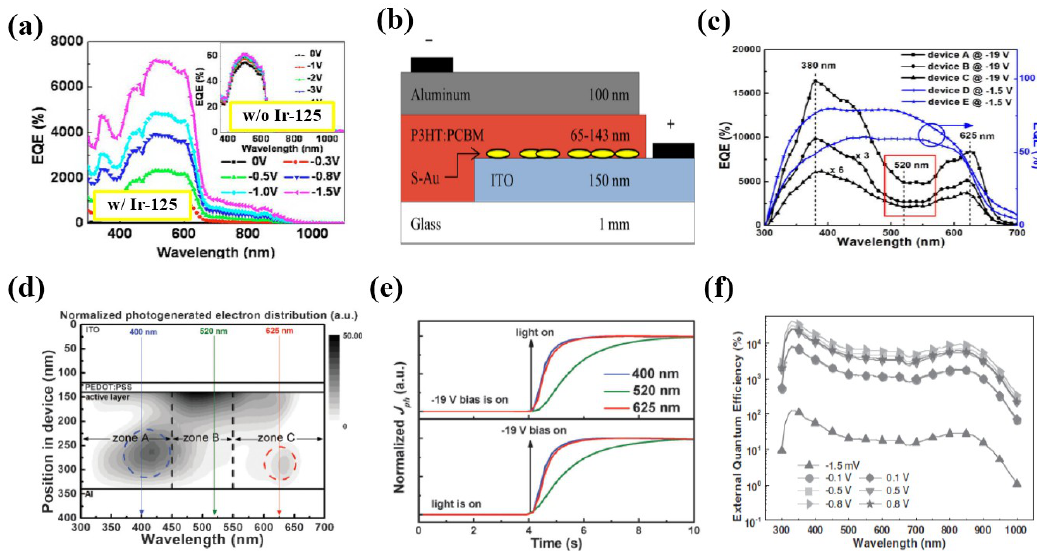
Figure 4. Device performances of various polymer PM photodetectors based on bulk heterojunctions made of organic semiconductors. ( a ) EQE spectra of ITO/PEDOT:PSS/P3HT:PCBM (1:1)/Ca/Al with and without Ir-125 doped in active layer (Reproduced with permission from [60]. AIP Publishing , 2010); ( b ) Structural diagram of ITO/s-Au/P3HT:PCBM/Al device (Reproduced with permission from [61]. AIP Publishing , 2014); ( c ) EQE spectra of ITO/PEDOT:PSS/P3HT:PC71BM/LiF/Al with different P3HT:PC71BM weight ratios (Reproduced with permission from [62]. Springer Nature , 2015); ( d ) Calculated wavelength dependent distribution of photogenerated electrons in the active layers of P3HT:PC71BM (100:1) without bias (Reproduced with permission from [63]. Royal Society of Chemistry , 2015); ( e ) Normalized transient photo current curves under light illumination at the wavelengths of 400 nm, 520 nm, and 625 nm, respectively for P3HT:PC71BM (100:1) device (Reproduced with permission from [63]. Royal Society of Chemistry , 2015); ( f ) EQE spectra measured under different bias voltages after UV light treatment for ITO/ZnO/PDPP3T:PC71BM (1:2)/Al device (Reproduced with permission from [64]. John Wiley and Sons , 2016).